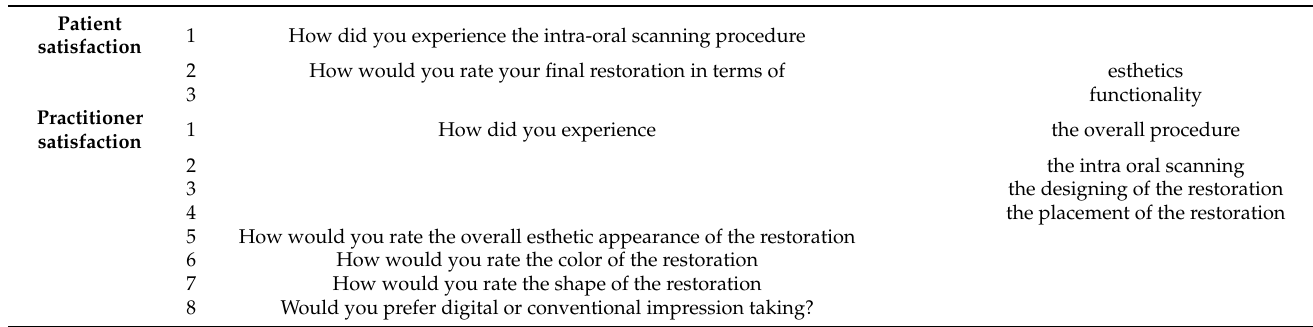
Table 2. Patient and practitioner questionnaire.